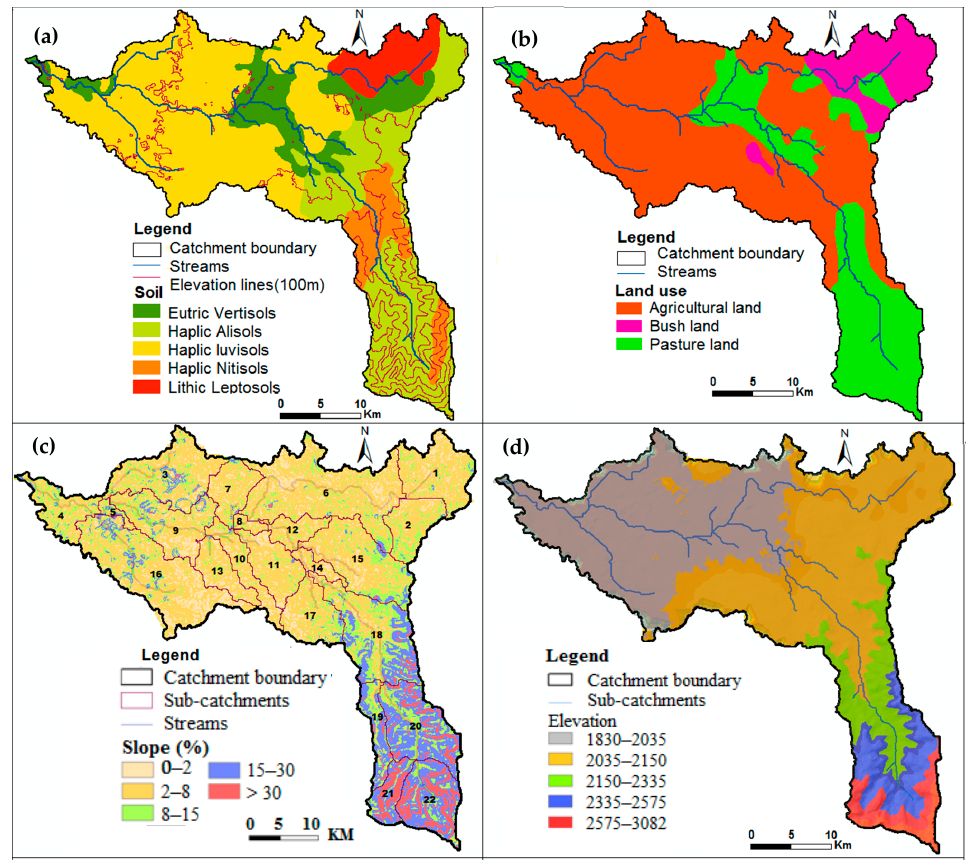
Figure 2. Koga catchment GIS data attributes: ( a ) soil, river network, and elevation lines; ( b ) land use; ( c ) sub-catchment boundaries and slope distribution; ( d ) terrain elevation map.